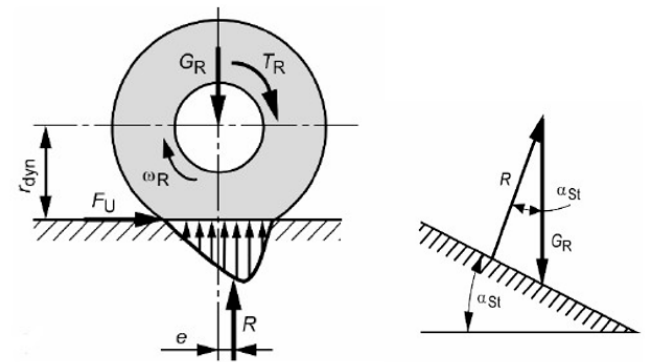
Figure 11. Forces and Torques Arrangement Due to the Contact Between Tire and Road.